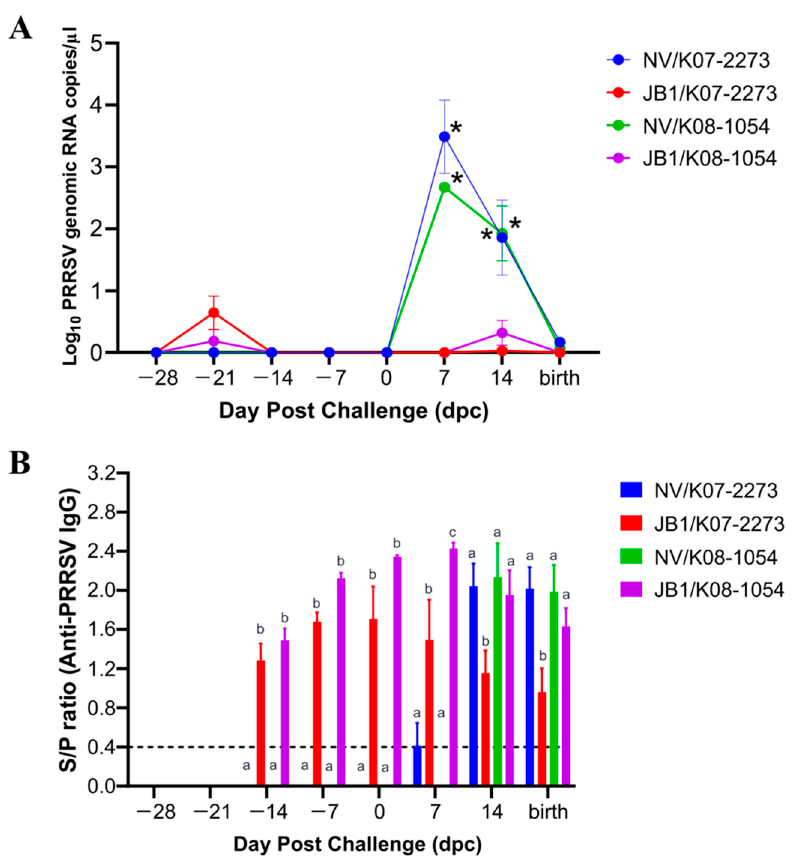
Figure 3. Mean values of the genomic copy number of PRRSV RNA and antibody response in the sera of pregnant sows from each group. ( A ) The genomic copy number of PRRSV RNA from pregnant sows post-vaccination and post-challenge. Data are shown as the means ± standard error of the mean (SEM). Asterisks indicate significant differences between the NV/K07–2273 and JB1/K07–2273 groups or between the NV/K08–1054 and JB1/K08–1054 groups (* p < 0.0001). ( B ) PRRSV-specific IgG response of vaccinated and challenged pregnant sows. Data are shown as the means ± SEM. Different letters represent significant differences among the experimental groups ( p ≤ 0.05, Tukey’s test, two-way ANOVA).